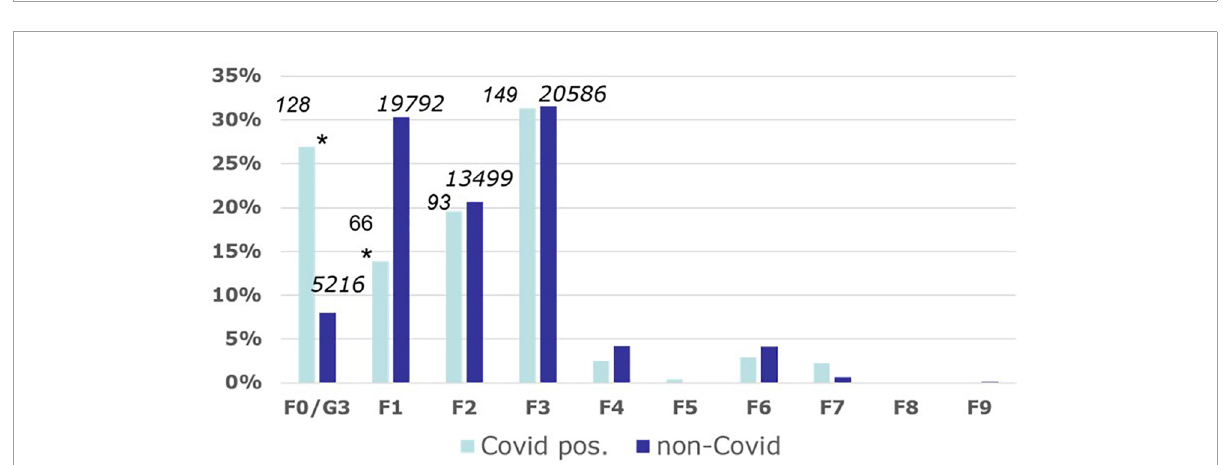
FIGURE3 Spectrum of mental disorders of COVID-19-infected psychiatric inpatients. Frequency of COVID-19-cases in different diagnostic groups of psychiatric inpatients of the LVR psychiatric hospitals as differentiated by the World Health Organization International Classification of Disorders, 10th revision (https://icd.who.int/browse10/2016/en#/V; last accessed 2 November 2021). The figures above each bar indicate absolute case numbers during the observation period 1 January 2020 until 30 June 2021. Asterisks indicate that the group differences were significant in Chi square tests ( p < 0.001). For example: The bars for the diagnostic group F0/G3 (organic mental disorders including dementias) indicate that 27% of all COVID-19-cases, but only 9% of the non-COVID-19-cases, were diagnosed with an F0/G3 disorder. F1, mental and behavioral